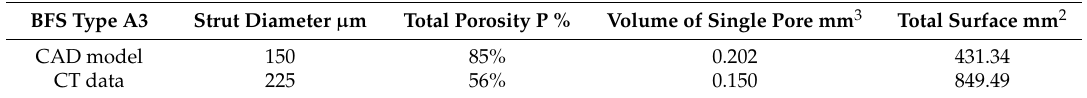
Table 3. Results of BFS structure geometry analysis using CT